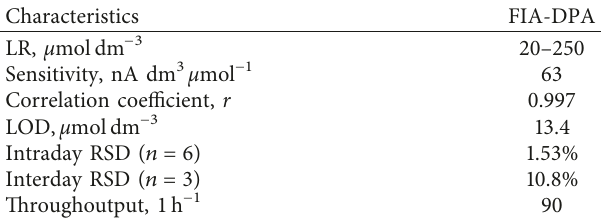
Table 2: Analytical characteristics of the proposed methods. Characteristics